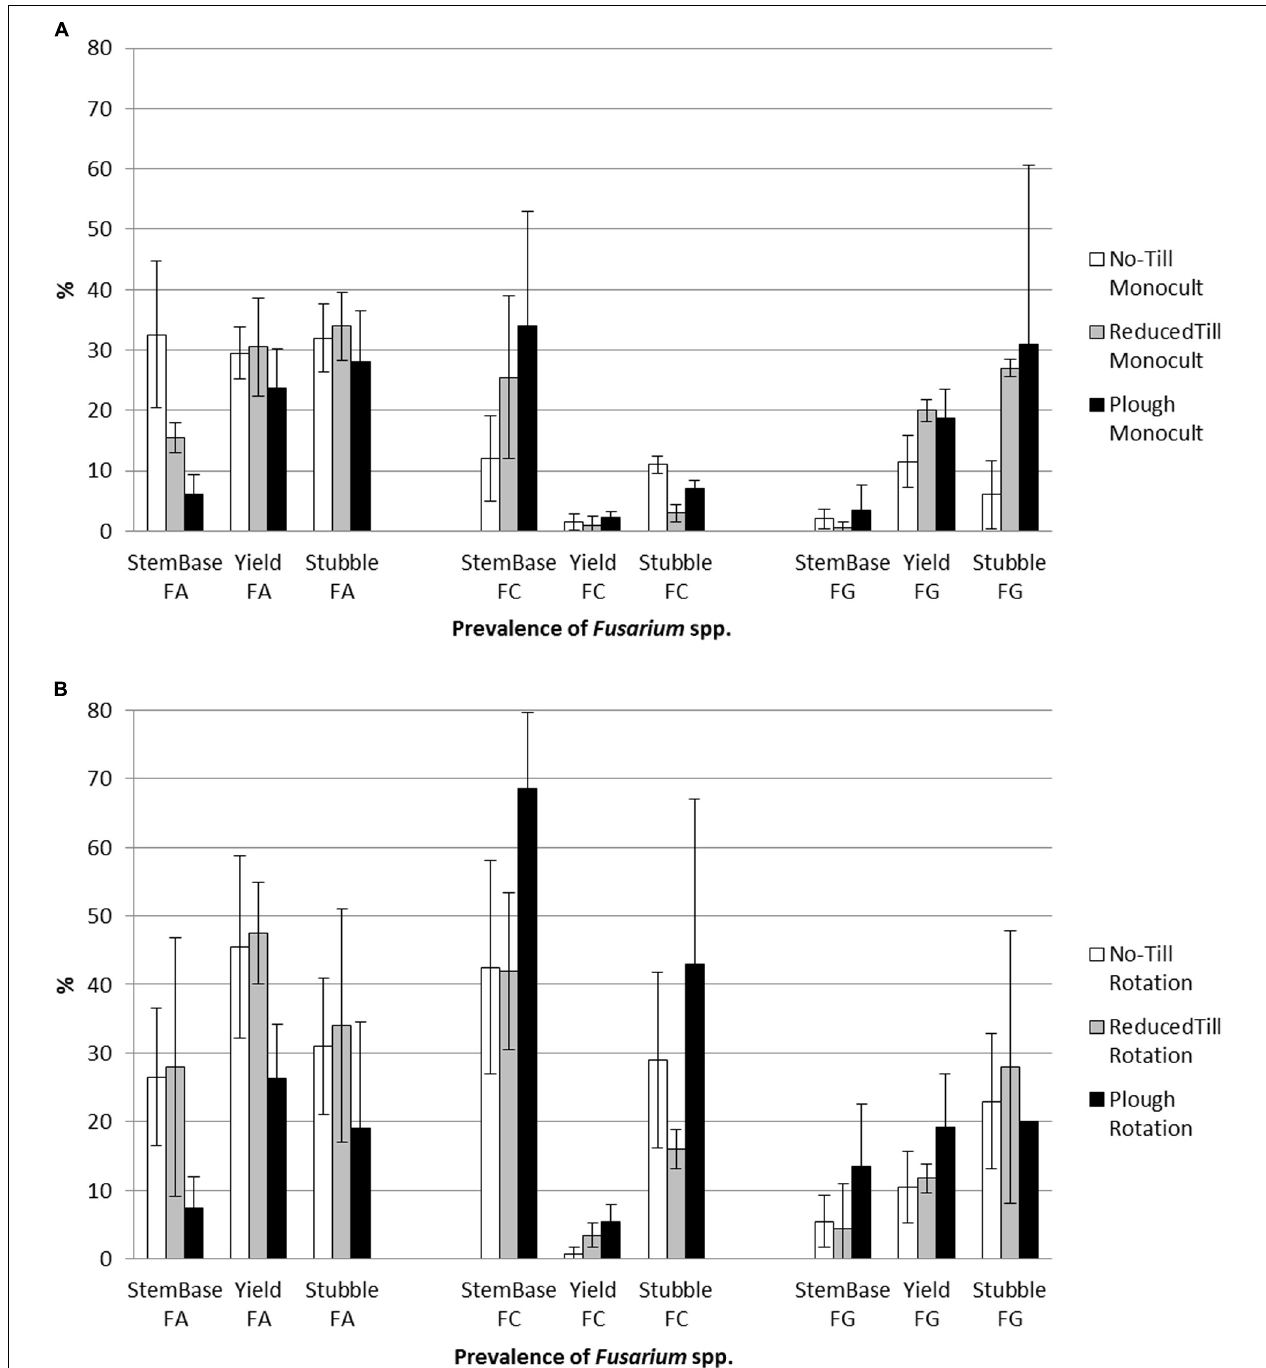
FIGURE 2 | The prevalence of toxins forming pathogens F. culmorum (FC) and F. graminearum (FG), and predominantly saprophytic species F. avenaceum (FA) on tillage treatments in (A) barley monoculture and (B) oats (crop rotation; oats is known to be more susceptible to F. culmorum than barley), on stem base 2 weeks after heading phase, yield during harvest, and at stubble after harvest (% ± SD; mean values, N = 4). See Supplementary Table S2 for statistical test